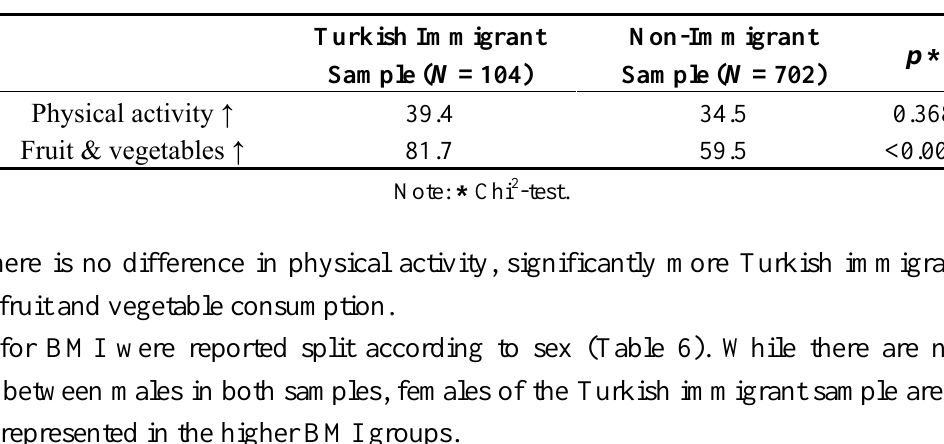
Table 5. Outcome quality: healthy lifestyle in DMP (%).